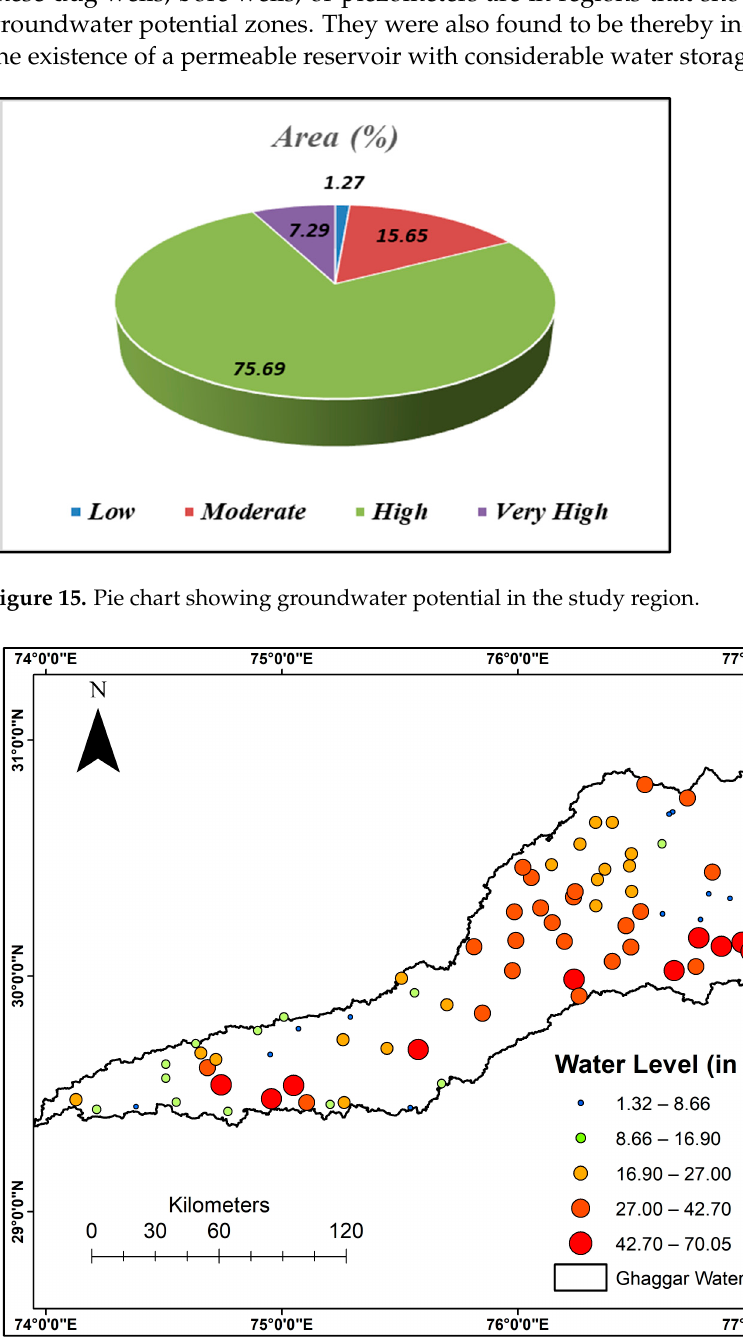
Figure 16. Groundwater level depth (Source: Central Ground Water Board).